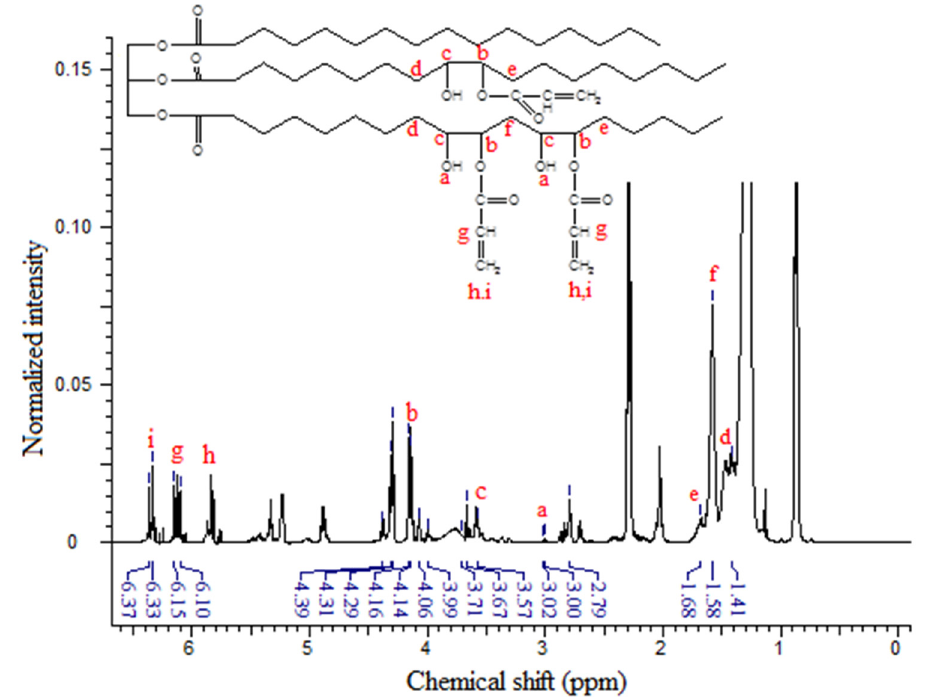
Figure 5. 1 H-NMR Spectrum of